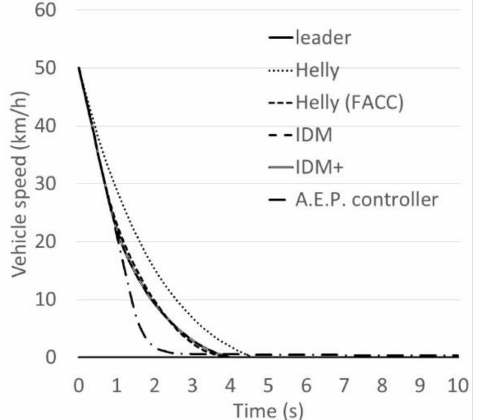
Figure 11. The following vehicle’s speed transition of case No.2. The modified model performs better. The braking ability of the Helly (FACC) model is comparable to that of IDM or IDM+. It should be noted here, that the A.E.P.